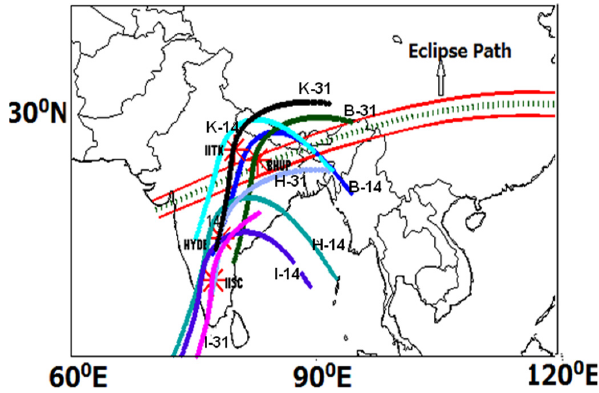
Fig. 1. Map showing the path of maximum obscuration for total solar eclipse of 22 July 2009, location of the stations in the Indian region, paths of the satellites designated by PRN 14 and 31. “K” stands for Kanpur, “B” for Varanasi, “H” for Hyderabad and “I” for IISc